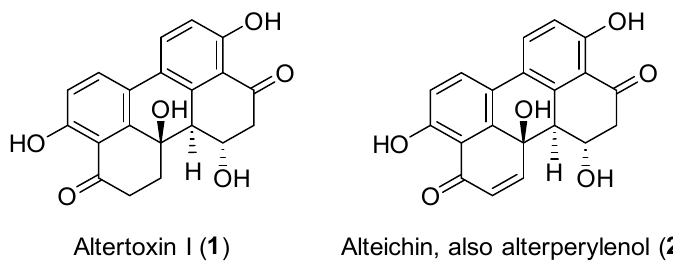
Figure 3. Pathogenicity assays on host Abate Fetel pear fruits. ( A ) Pathogenicity test on pear fruits; ( B ) severity (cm) of internal lesions on pear fruits.